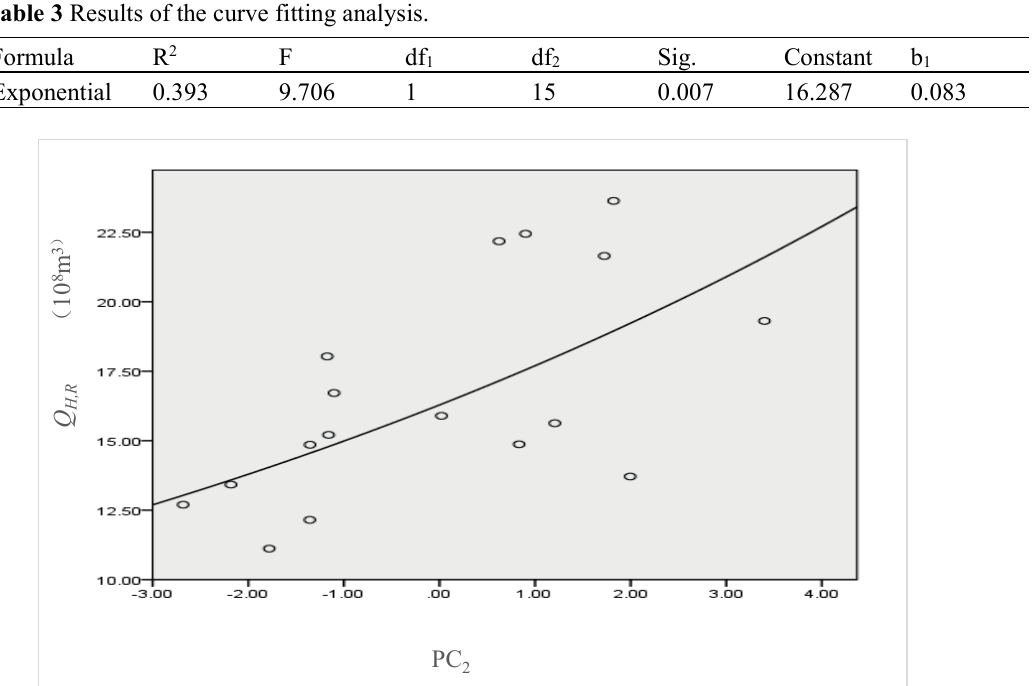
Fig. 2 The relationship between PC 2 and Q H,R . The solid line shows the fitted